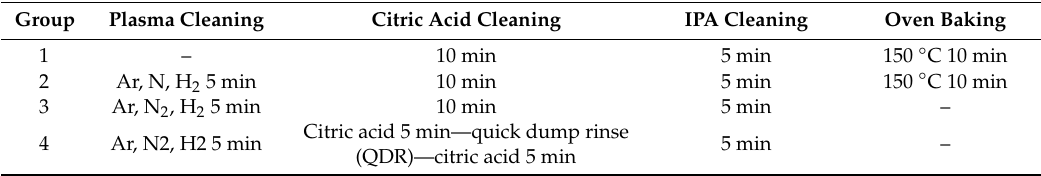
Table 2. Parameters setting of di ff erent cleaning pretreatment before bonding.